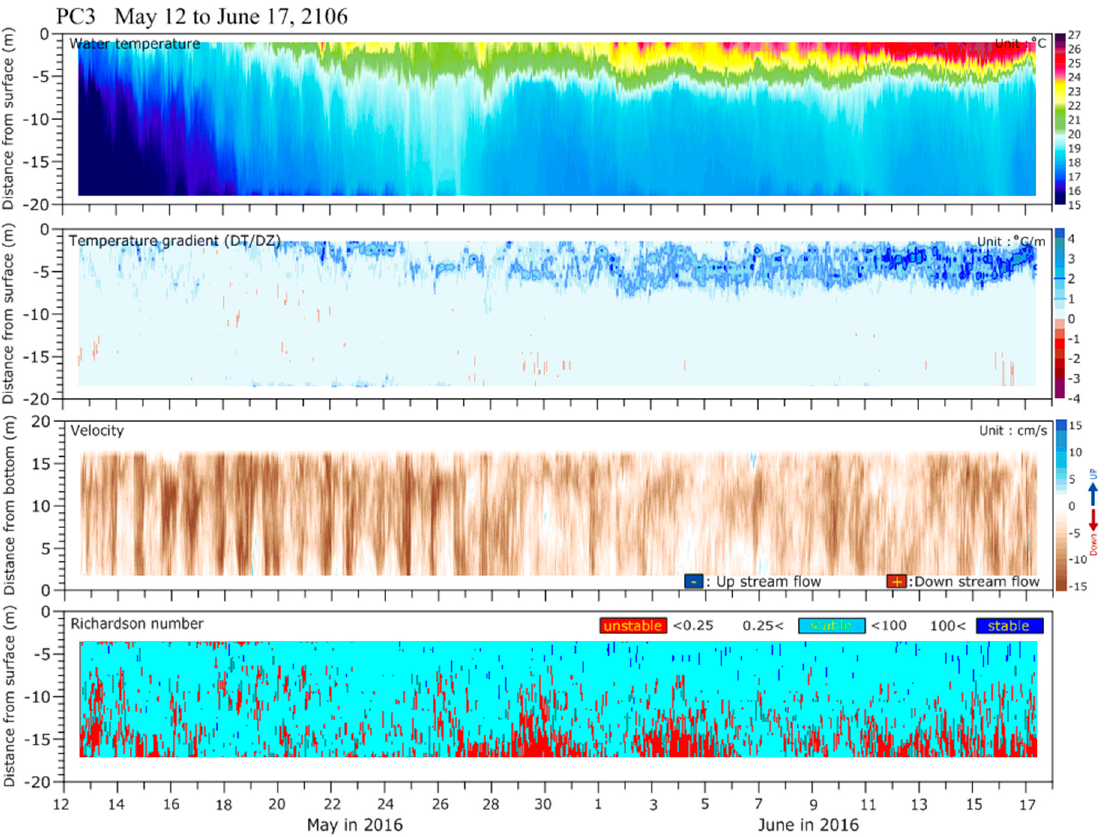
Figure 8. Profiles and time series of the water temperature, flow velocity, and Richardson number at PC3.